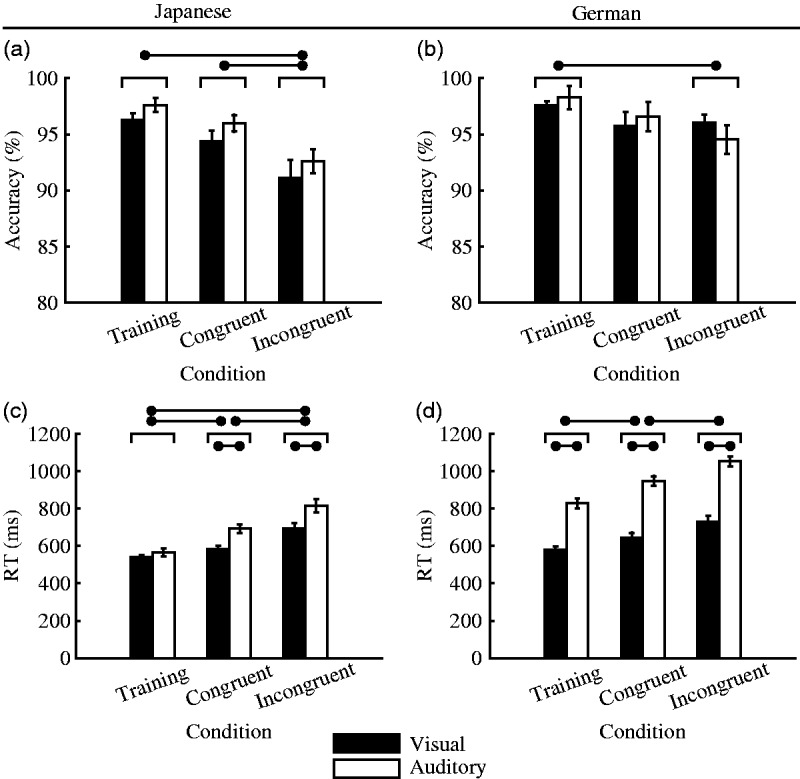
Average task performance accuracy (top figures: a and b) and
RT (bottom figures: c and d) shown for each condition and
modality. The figures were drawn using the dataset from
Japanese (left figures: a and c) and German (right
figures: b and d) participants. Error bars indicate
standard errors. The results of pairwise comparisons are
represented by horizontal bars
(p < .05, Tukey-corrected).RT = response time.